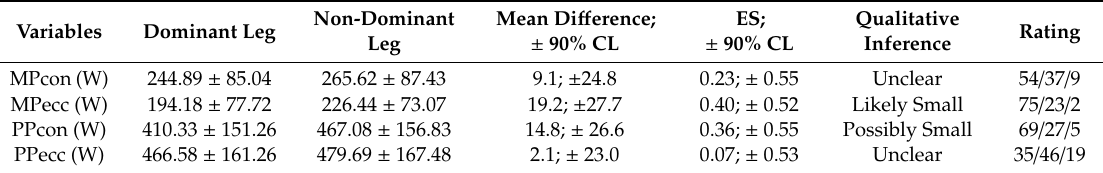
Table 1. Mean di ff erences ± SD in power variables among dominant and non-dominant limbs along with e ff ect sizes (ES) and qualitative inferences.